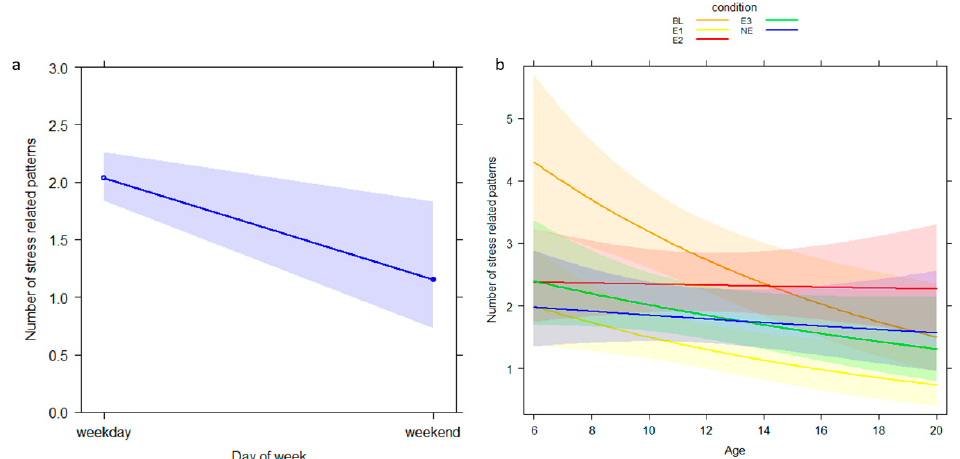
Figure 3. Effect plot of variables having a significant influence on the number of stress related patterns. The number of stress related patterns ( Y axis): ( a ) decreases during weekend days ( ( X axis) and ( b ) varies according to age ( X axis) and condition. The band represents the confidence interval.